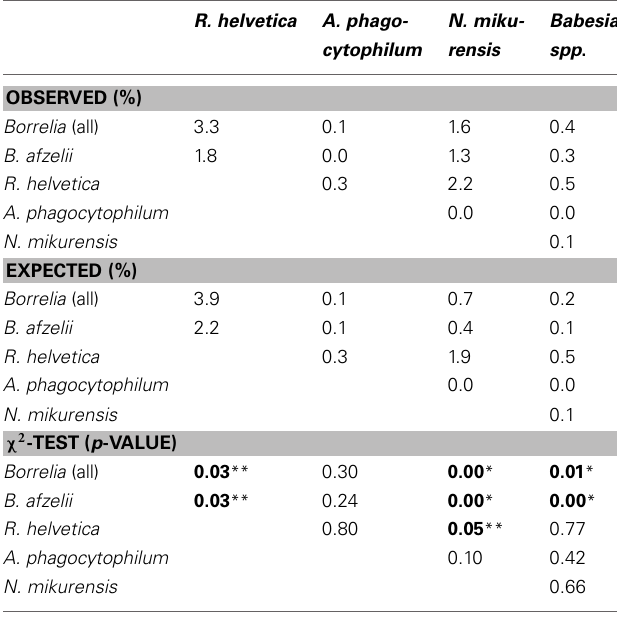
Table 3 | Observed and expected coinfections.